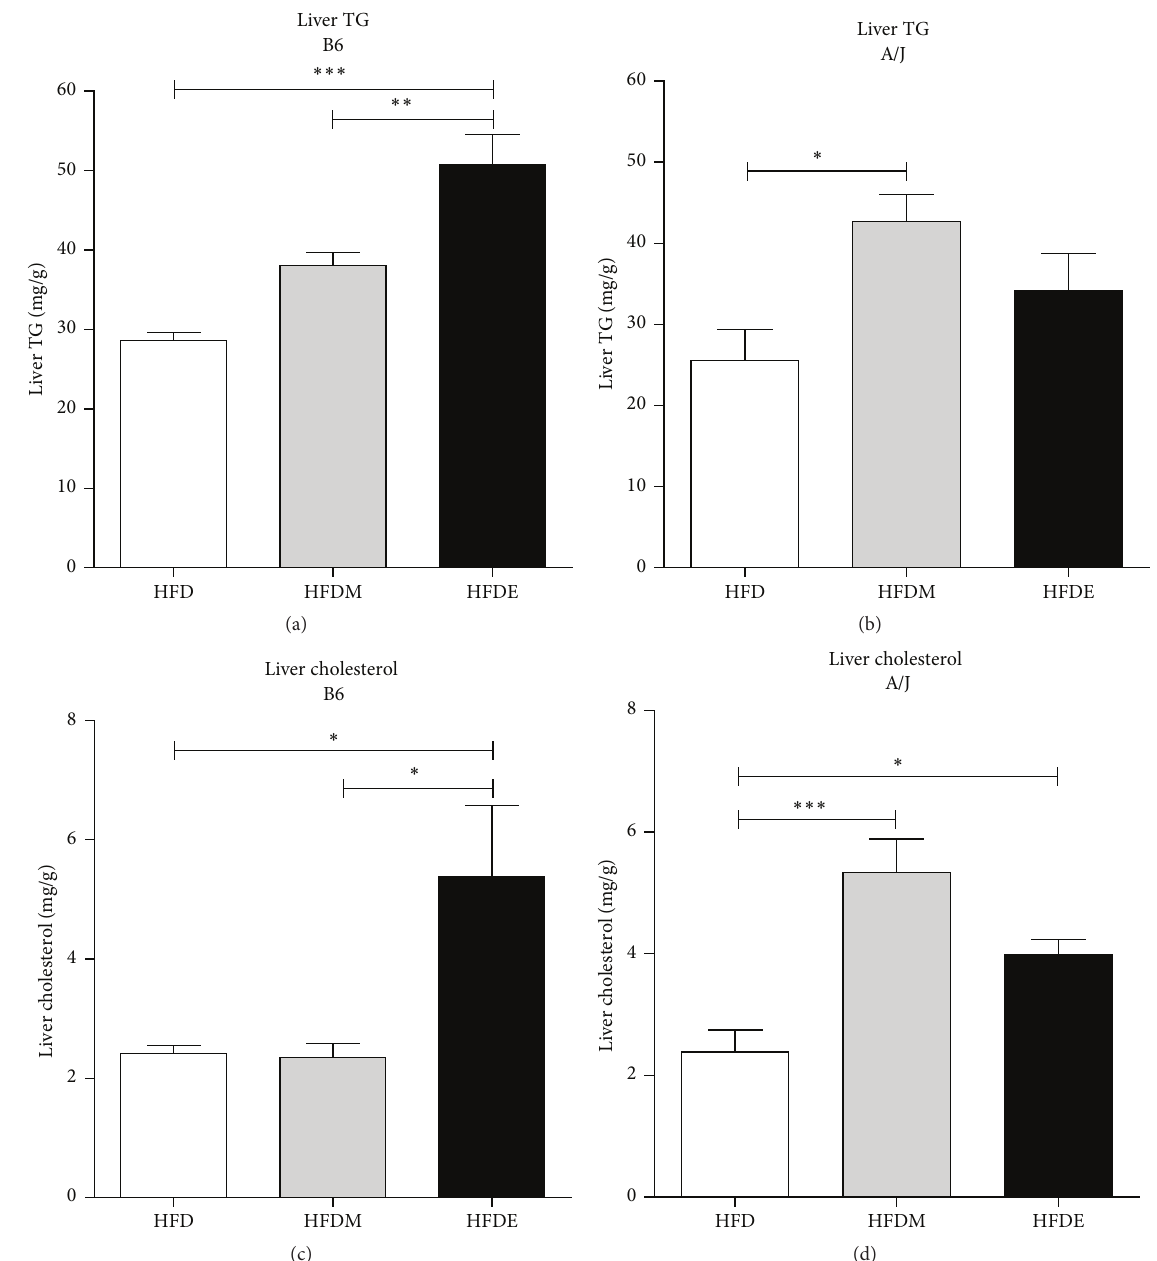
Figure 3: Triglycerides and cholesterol contents in the liver. B6 and A/J mice were fed with HFD, HFDM, and HFDE for 10 weeks. The liver was harvested, the total lipid was extracted, and the liver triglycerides ((a) and (b)) and liver cholesterol ((c) and (d)) were measured. Results from both B6 and A/J mice ( 𝑛 ≥ 5 ) were evaluated by ANOVA one-way and Tukey as a posttest. Values represent means and standard error. The differences are represented by ∗ 𝑃 < 0.05 , ∗∗ 𝑃 < 0.01 , and ∗∗∗ 𝑃 < 0.001 . TG: triglycerides, HFD: high fat diet, HFDM: HFD containing maltodextrin, HFDE: HFD containing